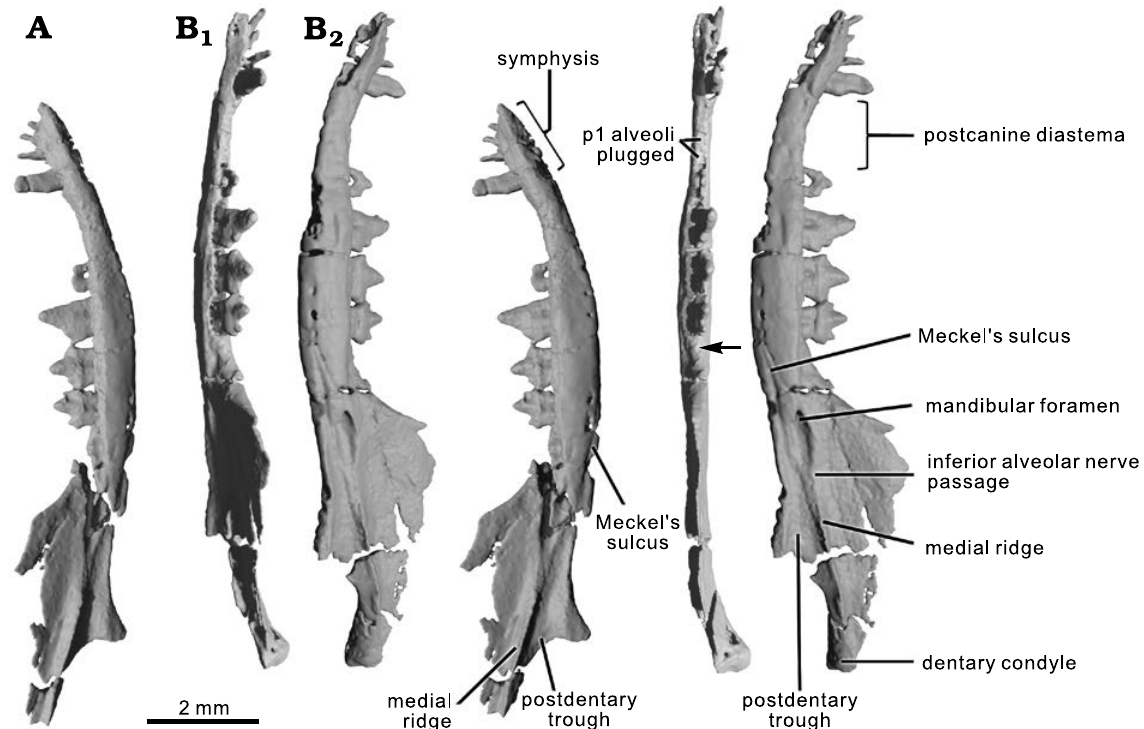
Fig. 3. CT rendering of the mammaliaform Hadrocodium wui Luo, Crompton, and Sun, 2001 (holotype, IVPP 8275) from the Lower Lufeng Formation, Lower Jurassic of Yunnan, China. A . Left mandible in medial view (stereopairs). B . Right mandible in tilted dorsal view (B 1 , stereopairs), p1 is lost but the p1 position is indicated by plugged alveoli; arrow indicates the retro-molar space; and medial view (B 2 ,